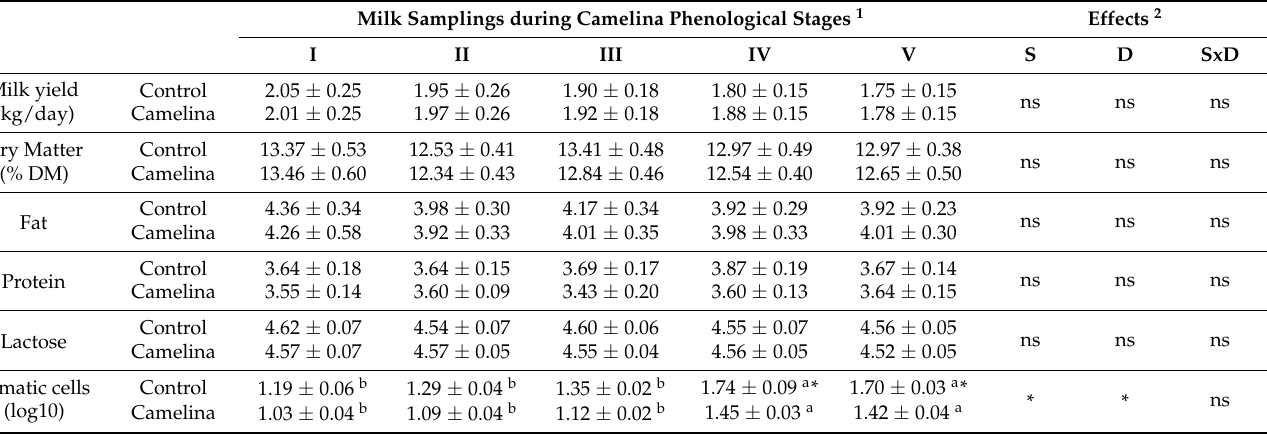
Table 6. Chemical composition (mean ± standard error) of goat milk collected during different phenological stages of